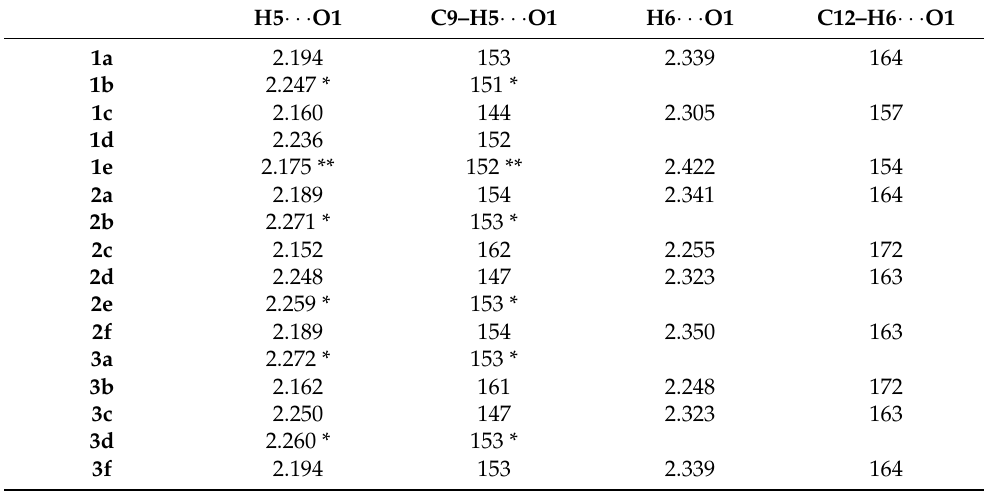
Table 4. Selected geometry characteristics of hydrogen bonds (distance, Å; angle, degrees) according to DFT